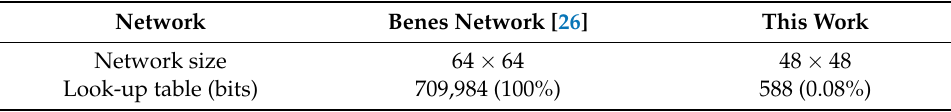
Figure 29. Forty-eight-input switching network architecture for ( p , c, 𝑃 (cid:3014) ) = (42, 29, 48). Table 3. Comparison of distinct switching networks. Table 3. Comparison of distinct switching